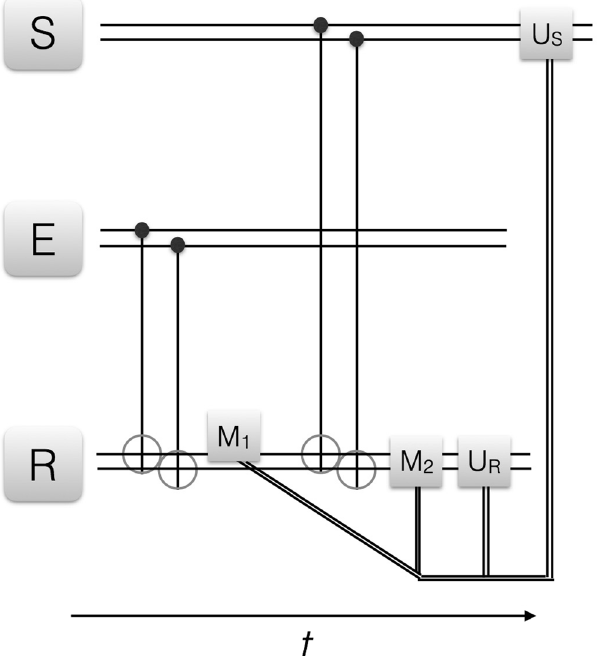
Figure 3. Quantum reinforcement learning for multiqubit system, I. We depict the circuit representation of the proposed learning protocol. S, E and R denote the agent, environment and register two-qubit states, respectively. CNOT gates between the respective pairs of qubits in E and R as well as in S and R are depicted with the standard notation. M 1 is a measurement in the computational basis chosen on the first qubit of the register, M 2 is a measurement in the computational basis chosen on the two-qubit state of the register, while U S and U R are local operations on agent and register, respectively, conditional on the measurement outcomes via a classical feedback loop. The double narrow lines denote classical information being fedforward, while the horizontal, double wider lines denote two-qubit states. The protocol can be iterated upon changes in the environment via reset of the